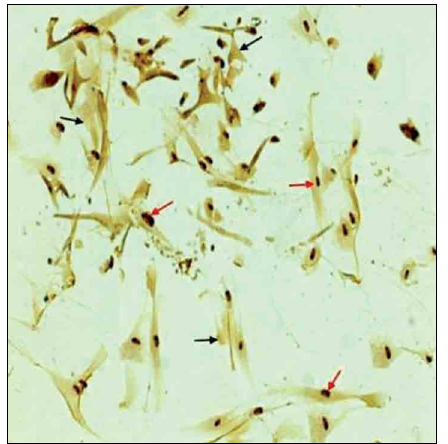
Figure-4: Cell proliferation assays. BrdU incorporation of BMMSCs for 24 h was evaluated. BrdU positive cells with brown stained nuclei (red arrows) and negative cells were unstained (black arrows). BrdU=Bromodeoxyuridine, BMMSCs=Bone marrow mesenchymal stem cells.